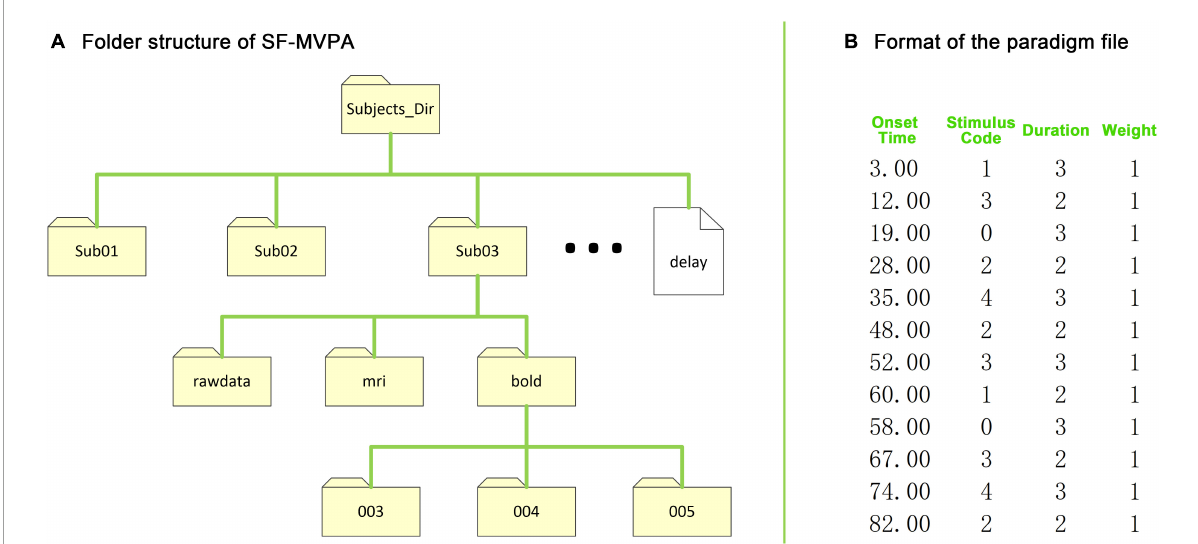
FIGURE2 Folder structure of SF-MVPA and format of the stimulus paradigm file. (A) The folder structure of SF-MVPA. All data are stored in the folder “Subjects_Dir” (data path). Each subject has a folder (e.g., “Sub01”). Subject folders must have the same prefix (e.g., Sub). If the user wants to perform slice timing correction in the preprocessing process, then the user needs to copy the delay file that contains the slice timing information to “Subjects_Dir.” All raw data, including structural and functional data, need to be copied to the folder “rawdata.” After performing raw data conversion (by clicking “1.DICOM to nii”), the structural data are stored in the folder “mri” while the functional data are stored in run folders such as “003,” “004,” which are automatically created by SF-MVAP (the number corresponds to the run number). Before GLM analysis and multivariate pattern analysis (MVPA), the stimulus paradigm files need to be copied to the run folders. (B) The format of the stimulus paradigm files. The format has four columns, which are the onset times (seconds) of the stimuli, the stimulus codes (0 represent the baseline condition), the durations of stimuli (seconds), and the weights of